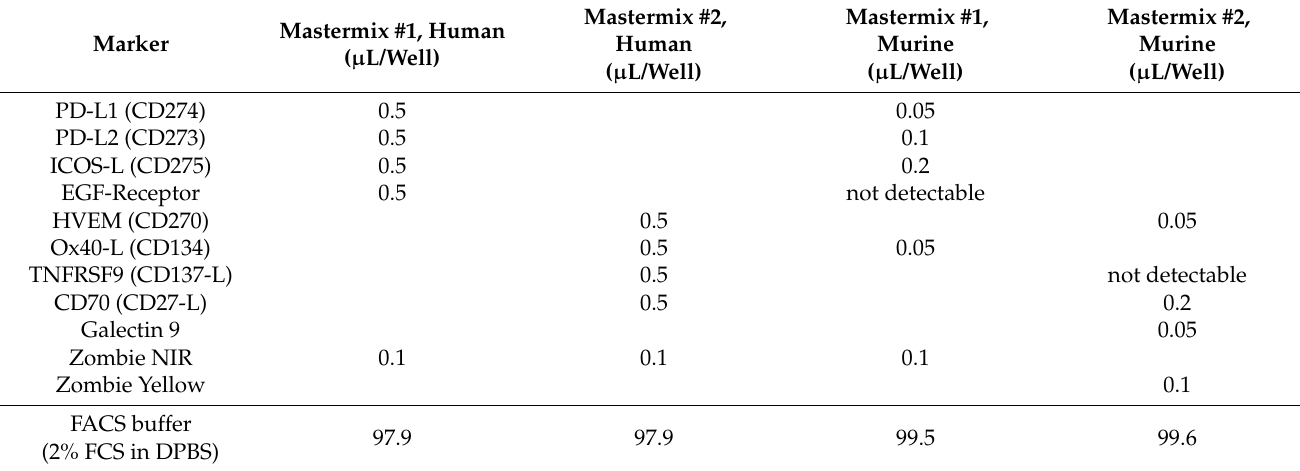
Table 2. List of antibodies used for the analysis of the surface expression of ICM and of EGFR on human and murine cancer cells by multicolor flow